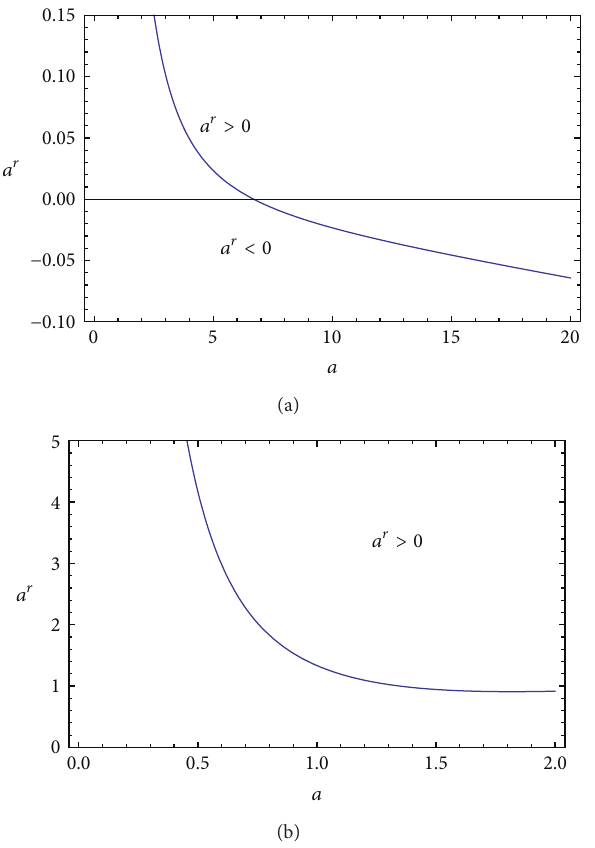
Figure 2: Plots for attractive and repulsive nature of Schwarzschild- de Sitter corresponding to 𝑀 = 1 and Λ = 0.01 (a) and Schwarzschild-anti-deSitterwith 𝑀 = 1 and Λ = −1 (b).Theworm- holes are attractive for 𝑎 𝑟 > 0 and repulsive for 𝑎 𝑟 < 0 .